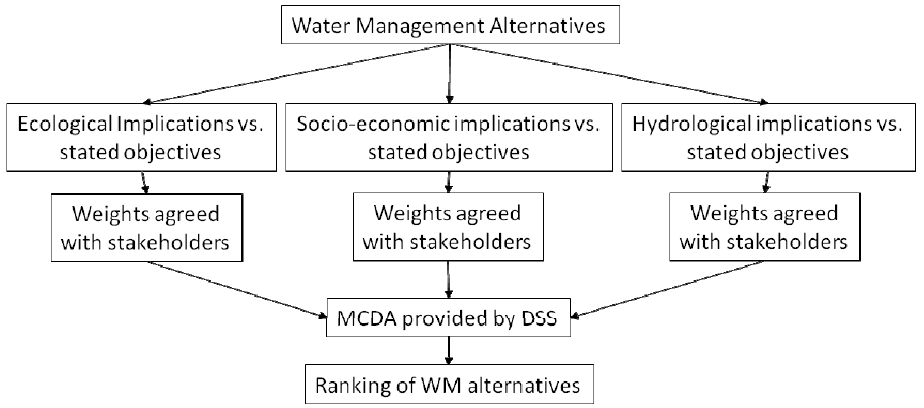
Figure 5. A proposal of a DSS framework for prioritizing water management alternatives by integrating multi-disciplinary approaches by means of multi-criteria decision analysis (MCDA) (adapted from [36]). WM, water